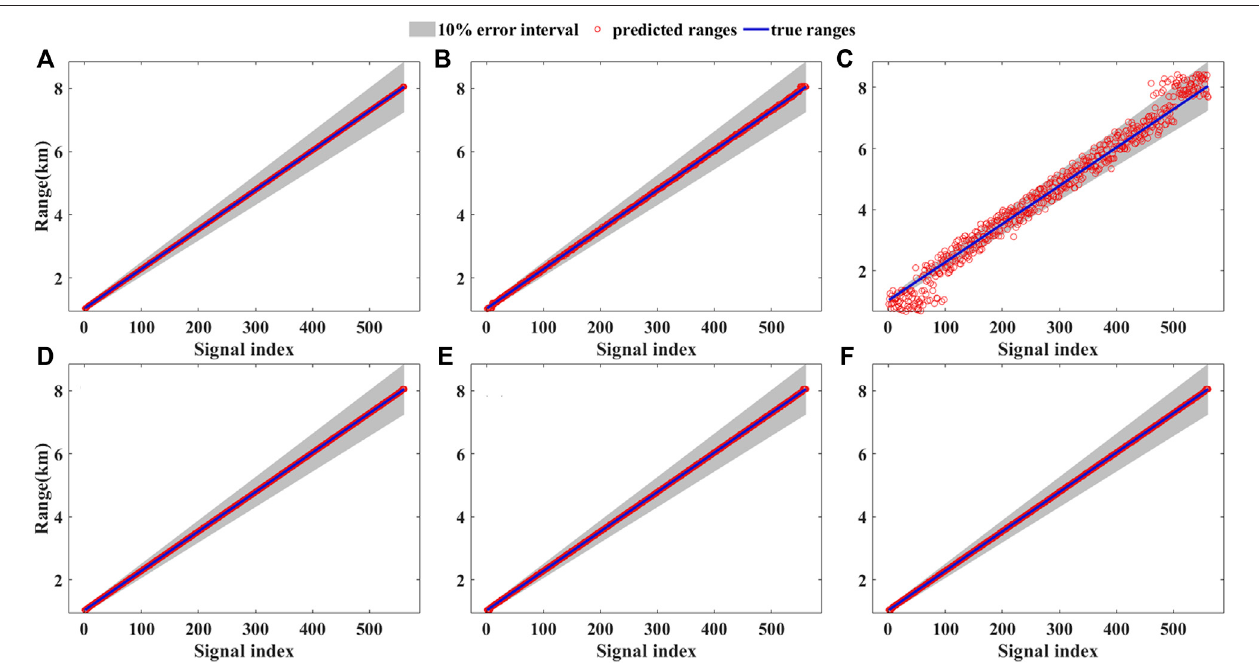
FIGURE 3 | Range localization results with various SNRs by K-ELM. (Top) The narrowband case of 235 Hz. (Bottom) The broadband case of {94,148 388} Hz with SNR of (A) (D) 5 dB, (B) (E) 0 dB, and (C) (F) -5 dB.